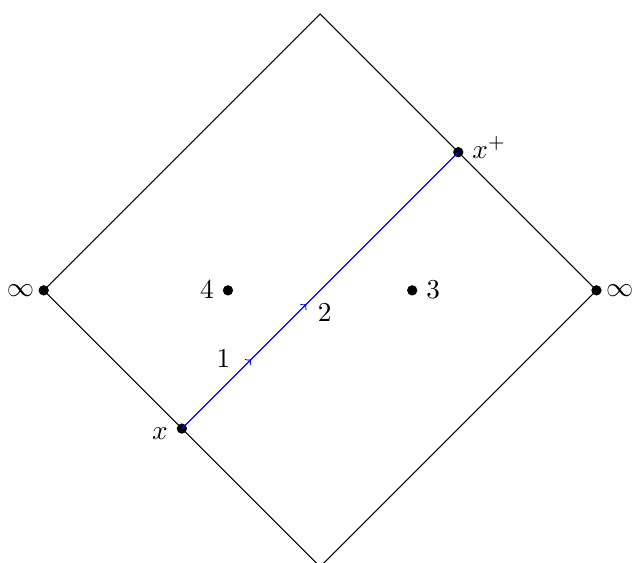
Figure 5. We consider the causal configuration where 4 > x and 3 < x + with 3 and 4 spacelike from each other. The points 1 and 2 are integrated over parallel null lines in the same null plane, with nonzero transverse separation. Here, we have suppressed the transverse direction, so the null plane appears as a single diagonal line (blue) from x to x + . (The conformal completion of the null plane also includes the left-moving diagonal line from x to ∞ on the left, and then from ∞ to x + on the